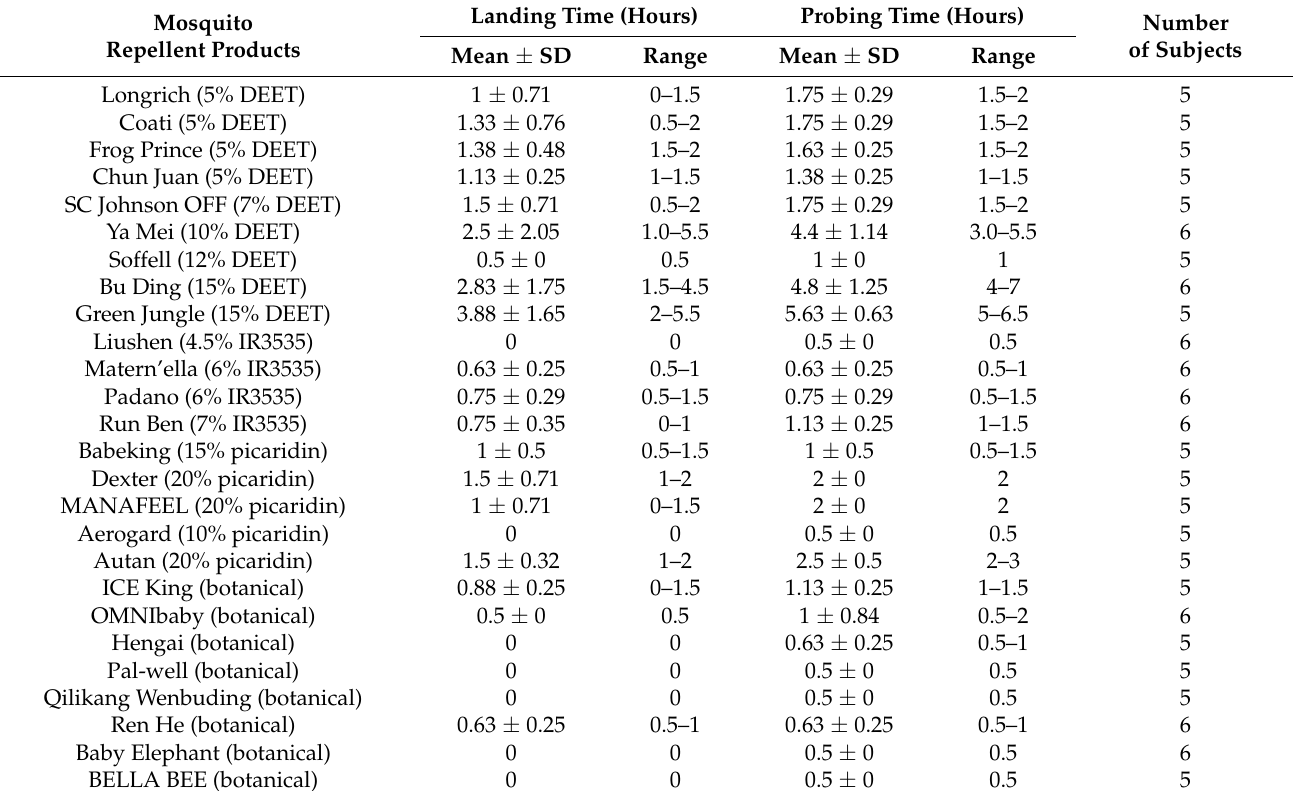
Table 3. Protection time of commercial mosquito repellents against Ae. albopictus bites 1